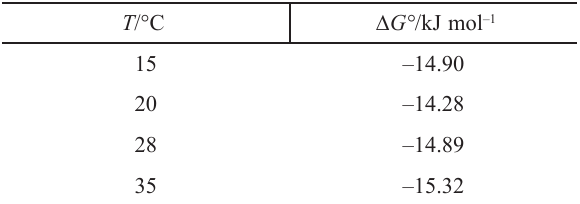
Table 4 – Values of Gibbs energy of HI extract adsorption on copper at different